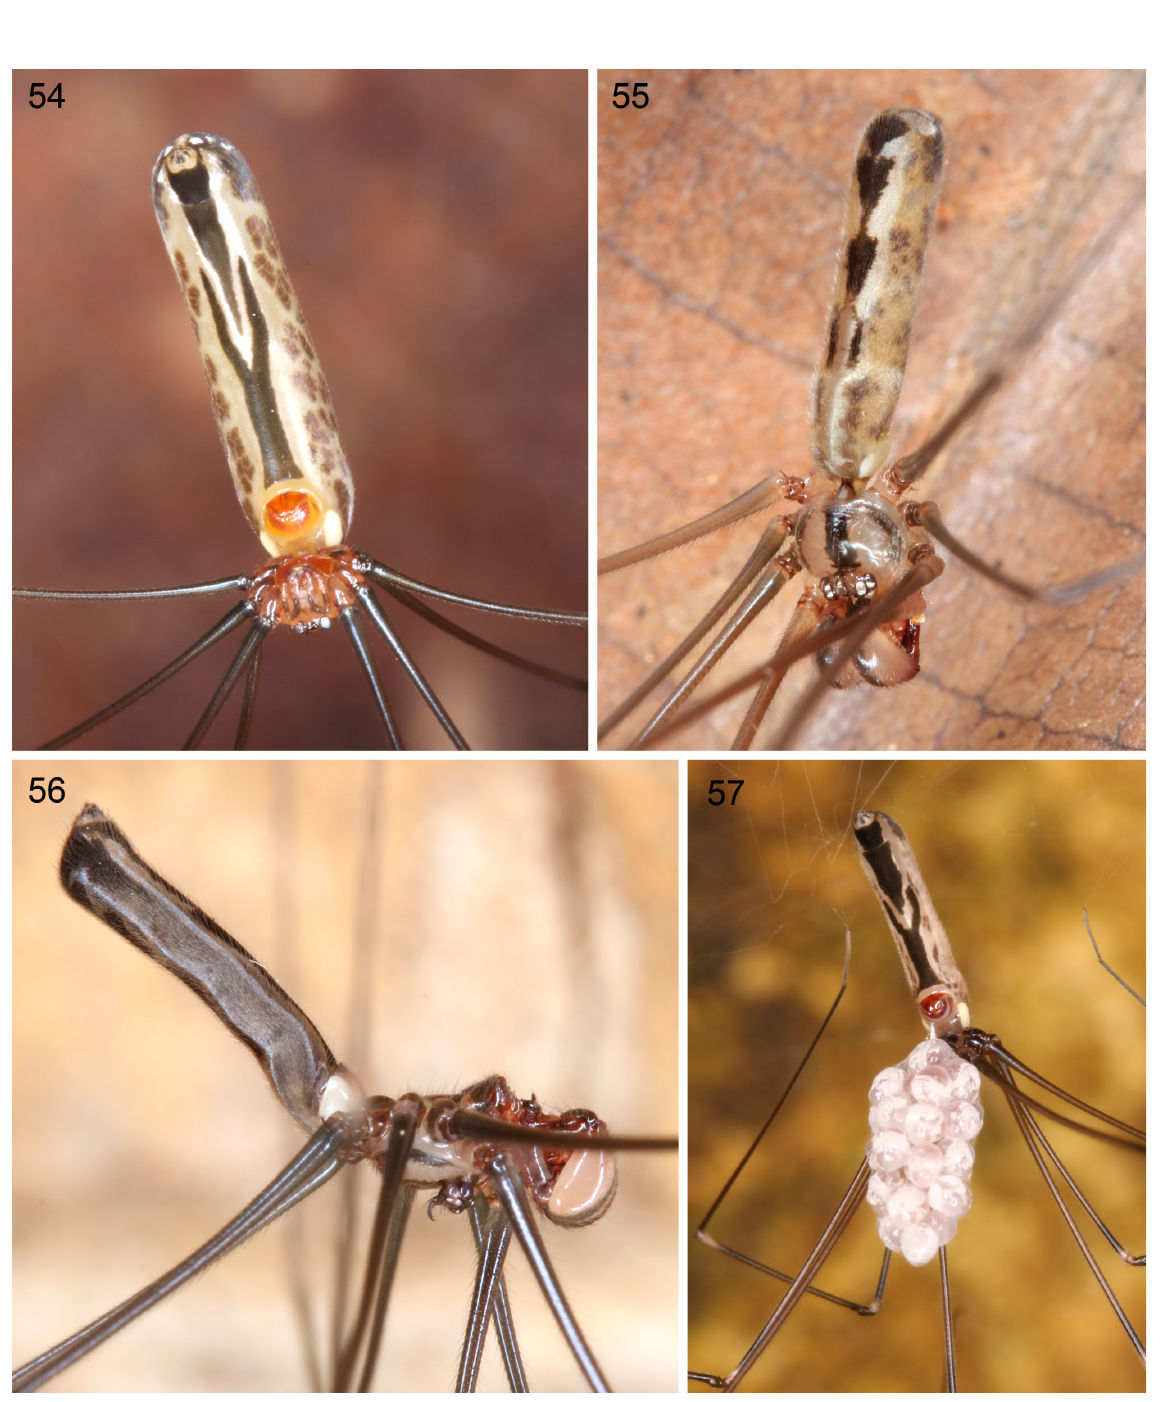
Figs 54–57. Live specimens. 54 . Pholcus arayat Huber, 2011, ♀, Pamulaklakin Forest Trail. 55–57 . Pholcus pagbilao Huber, 2011, ♂ from Loboc (55), ♂ from Mt. banahaw (56), and ♀ with egg-sac from Loboc